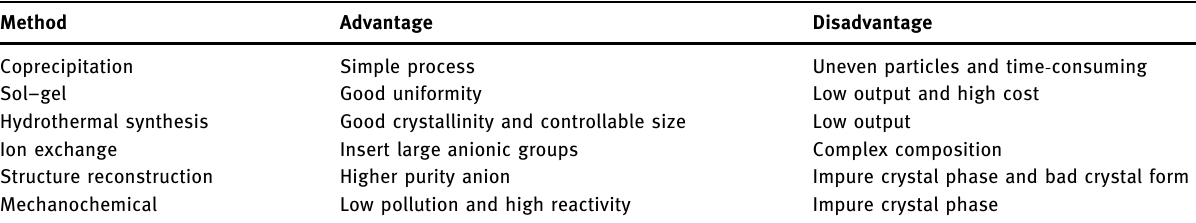
Table 3: Comparison of di ff erent preparation methods